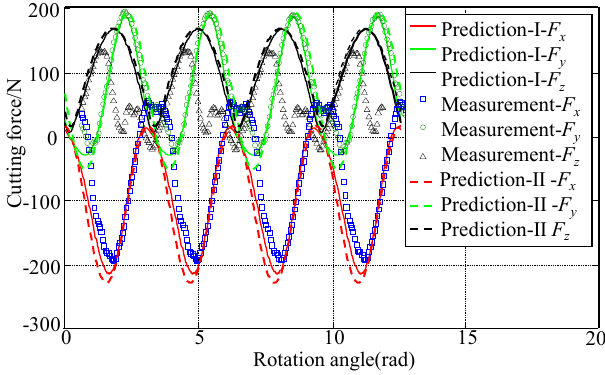
Figure 6. Comparison of measured and predicted forces; 15° inclination angle.